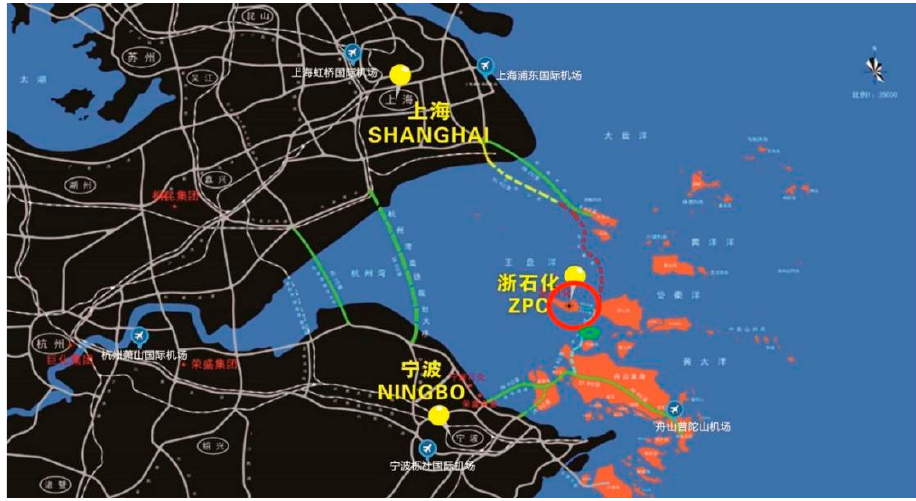
Figure 5. Geographical location of Zhejiang petrochemical.